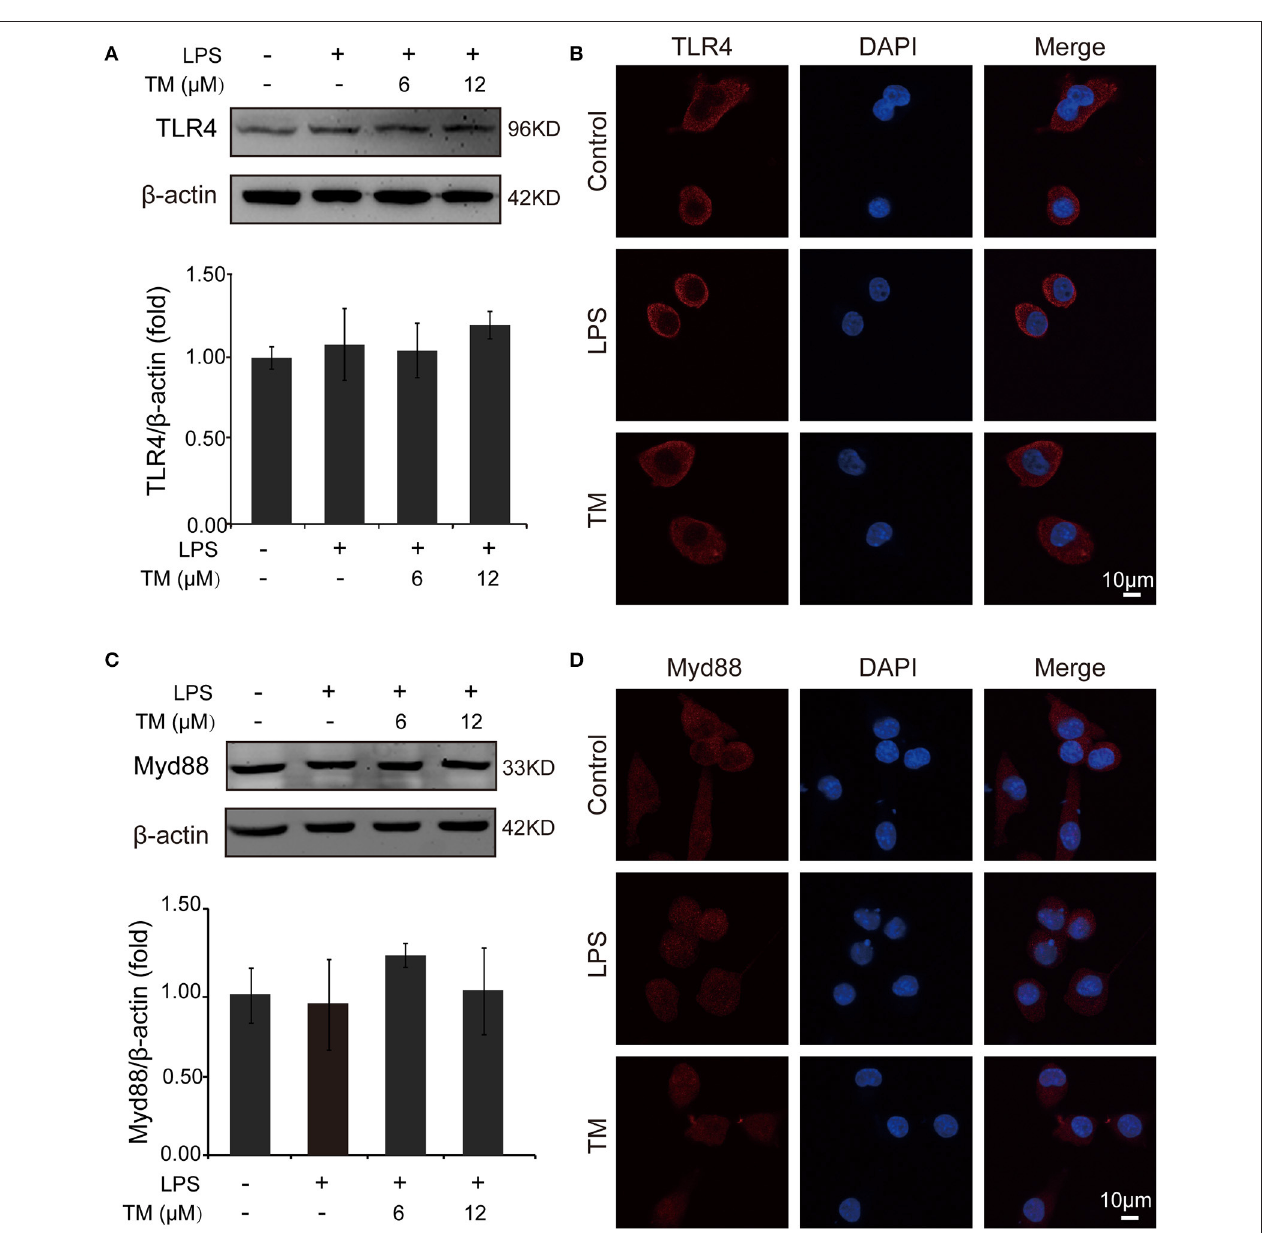
FIGURE 4 | TM-pretreatment has no effect on TLR4 and MyD88 in BV-2 cells induced by LPS. BV-2 cells were pretreated with 6, 12 µ M of TM, followed by treatment with 1 µ g/ml LPS for 18h. (A,B) The expression of TLR4 were determined by western blot (upper panel: representative pictures; lower panel: quantifications) and immunofluorescence. (C,D) The expression of Myd88 were determined by western blot (upper panel: representative pictures; lower panel: quantifications) and immunofluorescence. The results are expressed as the mean ± SD . of at least three independent experiments ( N ≥ 3).